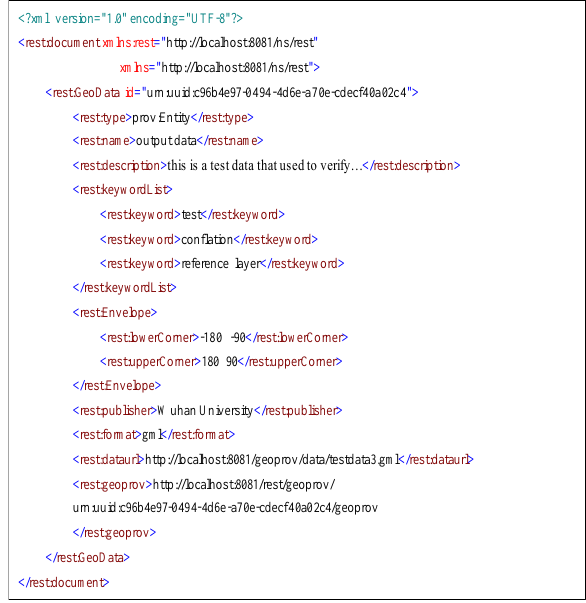
Figure 2. Example of a Data resource represented in XML